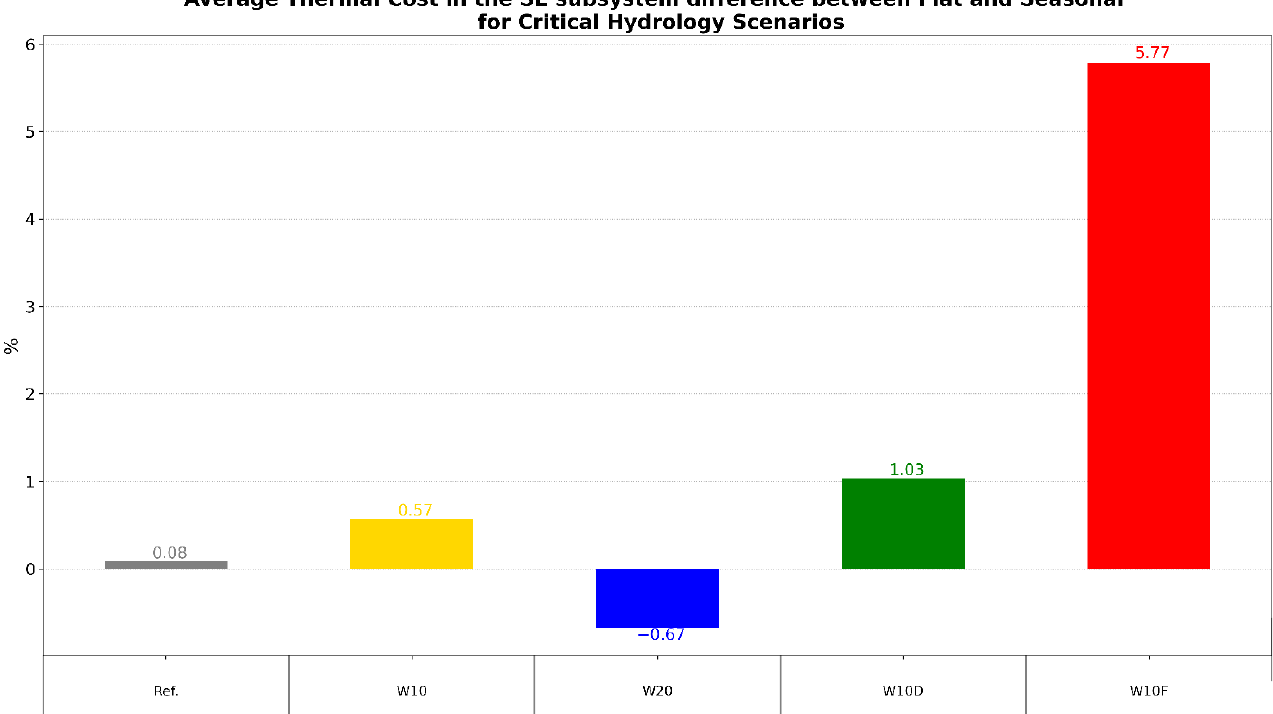
Figure 6. Percentage difference between flat and seasonal cases for average thermal cost in the southeast subsystem for scenarios with critical hydrology.